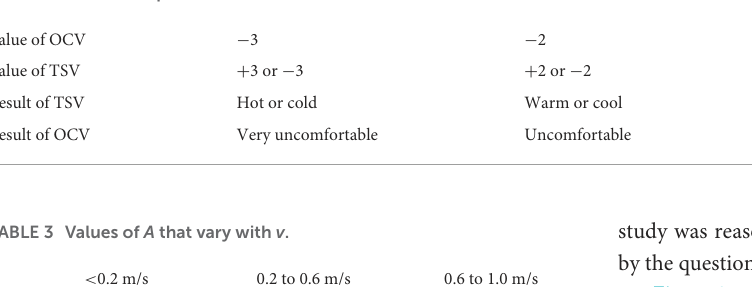
TABLE 2 Relationship between the TSV and OCV.